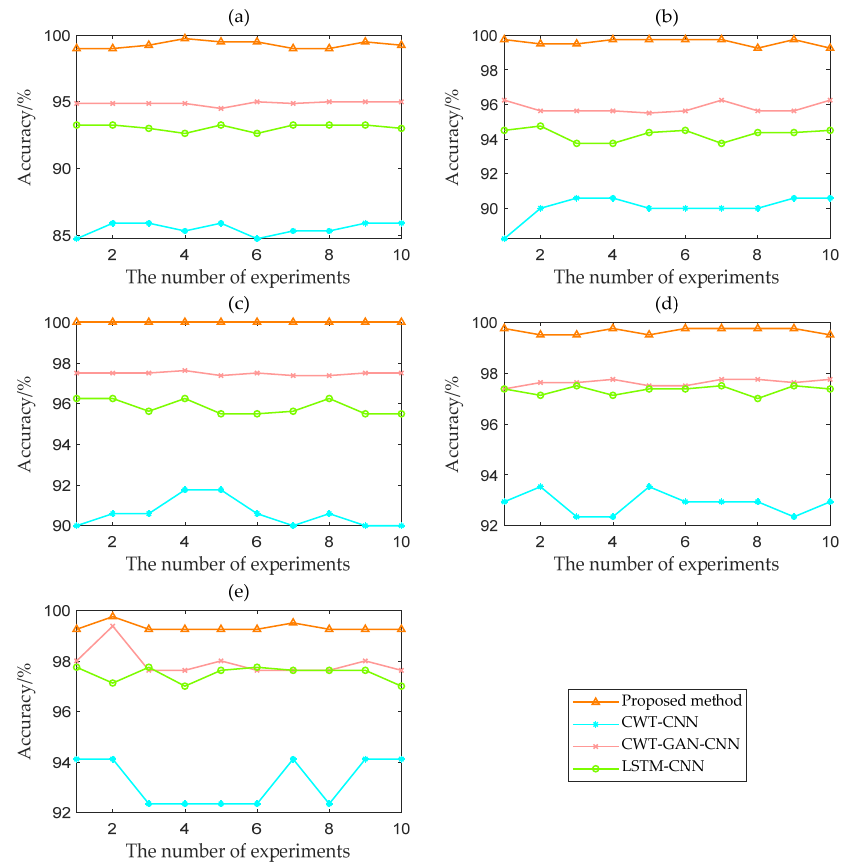
Figure 13. Accuracy curves of four models with different SNRs: ( a ) SNR = − 4 dB; ( b ) SNR = − 2 dB; ( c ) SNR = 0 dB; ( d ) SNR = 2 dB; ( e ) SNR = 4 dB.